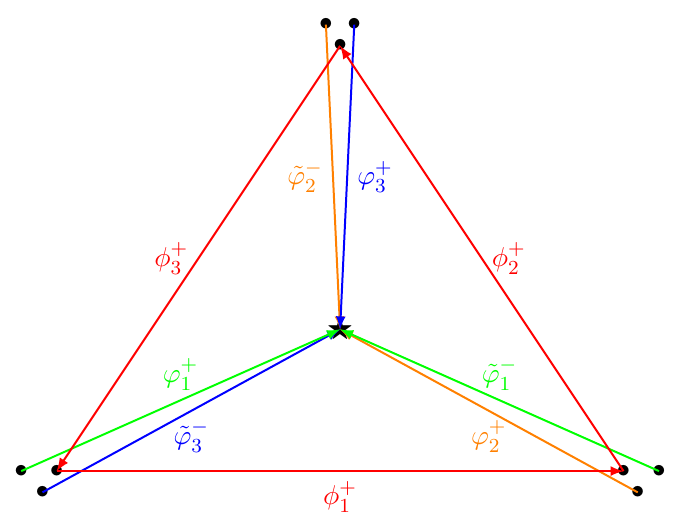
Figure 3. Various regular zero modes for C [( N; 0)] brane + point brane D . The F represents D , while (cid:15) denote the extremal weights of ( N; 0). The two shifted two points in the vicinity of each extremal weight state indicate the polarization of the zero mode. The (cid:30) + are maximal regular i zero modes on C [( N; 0)], while ’ + and ~ ’ (cid:0) are regular zero modes connecting C [( N; 0)] and D . i i Note that the conjugate modes, corresponding to arrows pointing the opposite directions, are not depicted